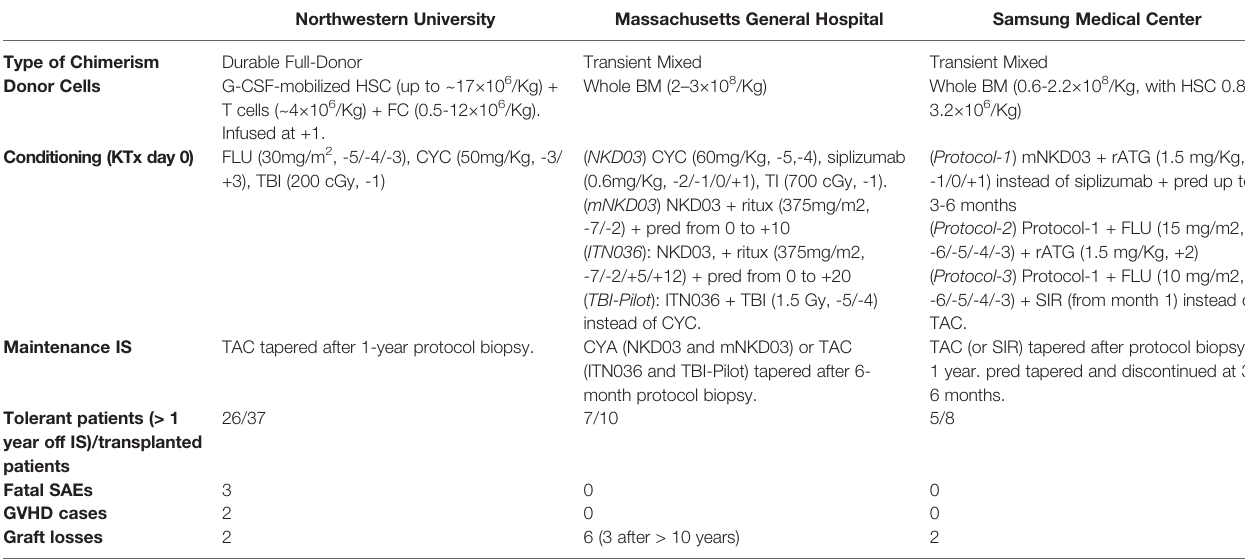
TABLE 1 | Tolerance-inducing protocols for kidney transplantation across MHC